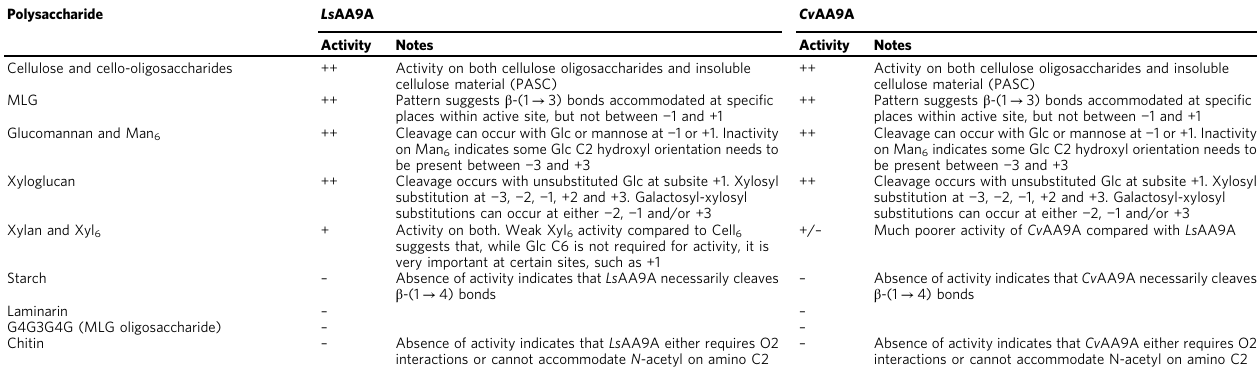
Table 1 Summary of activity assays on different substrates Polysaccharide